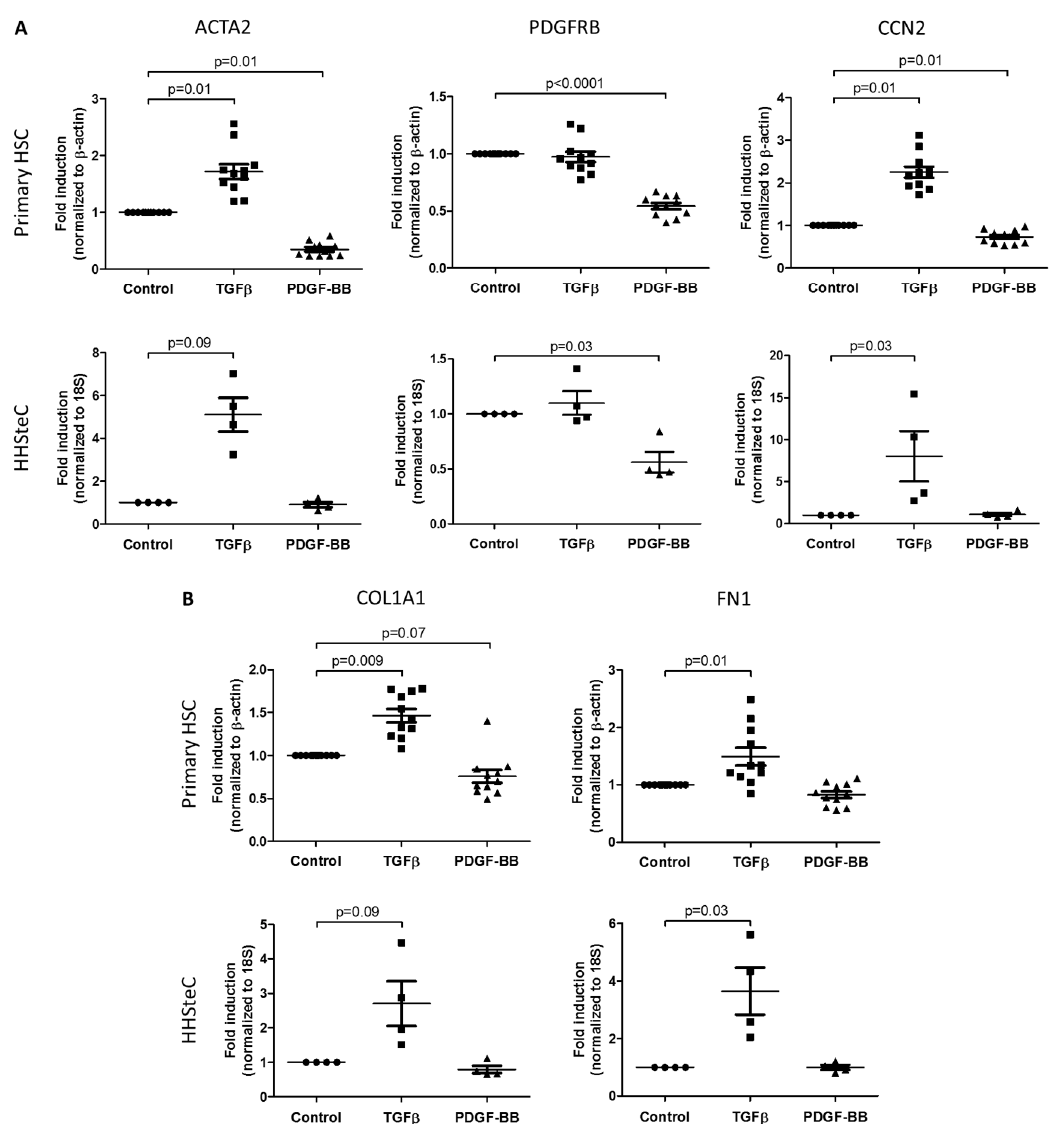
(Table 2). Cycle threshold (Ct) values of the untreated controls of each gene in all in vitro models used are shown in Supplementary Table S1 in order to demonstrate the di ff erences in basal gene expression levels.